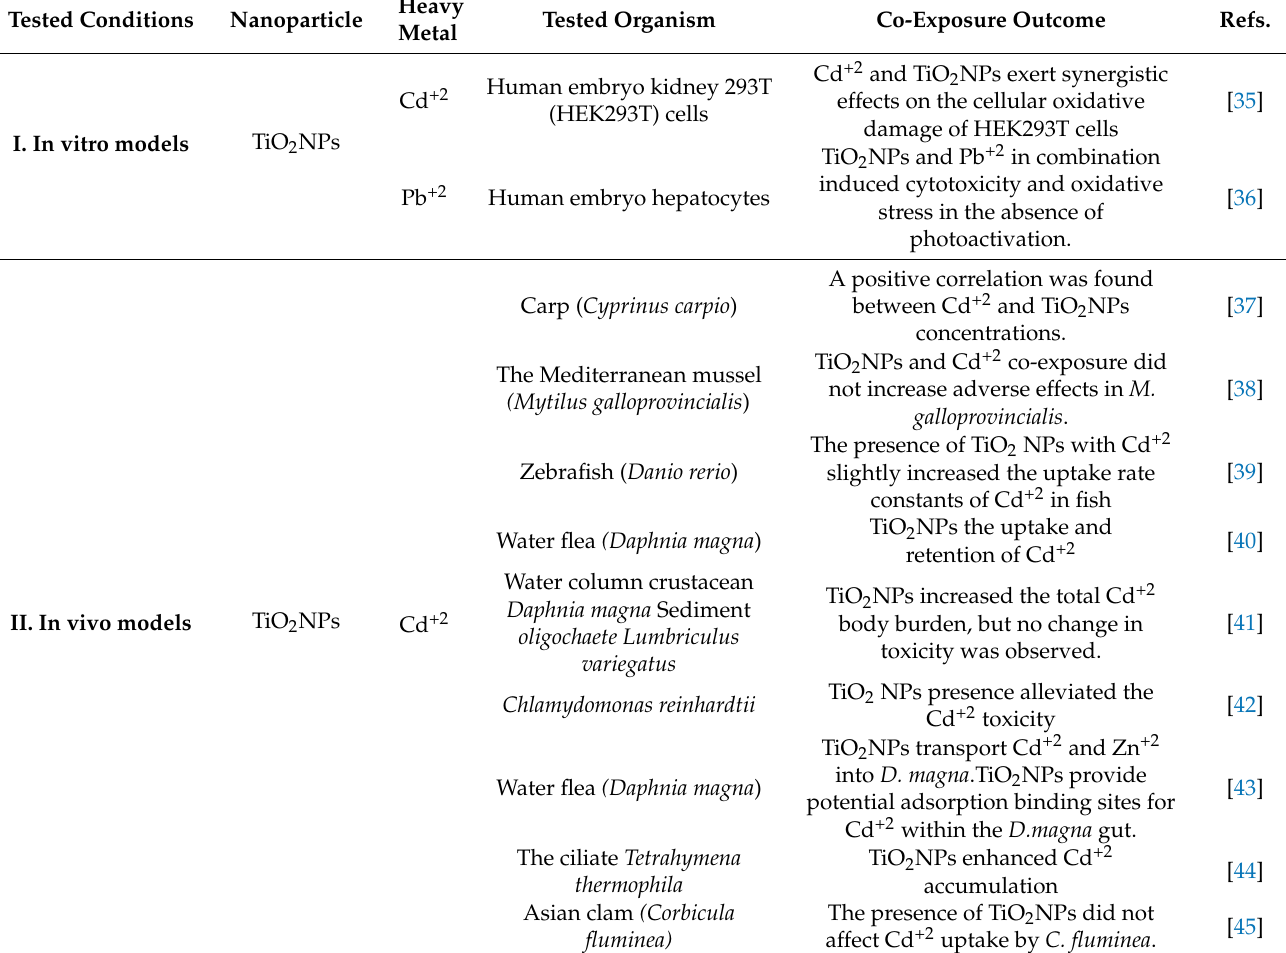
Table 1. Outcomes of co-exposure to engineered nanomaterial and heavy metals in different experimental models. Tested